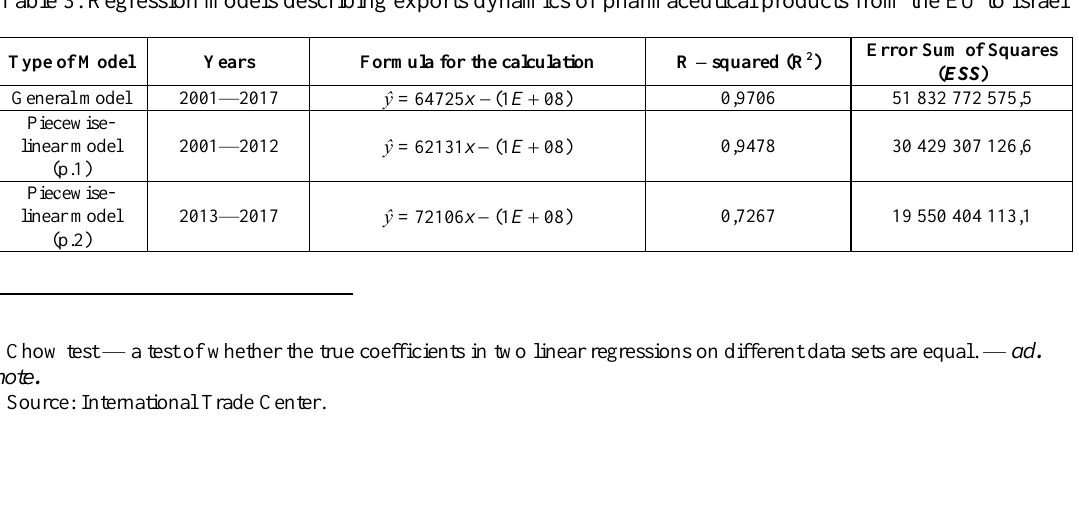
Error Sum of Squares ( ESS